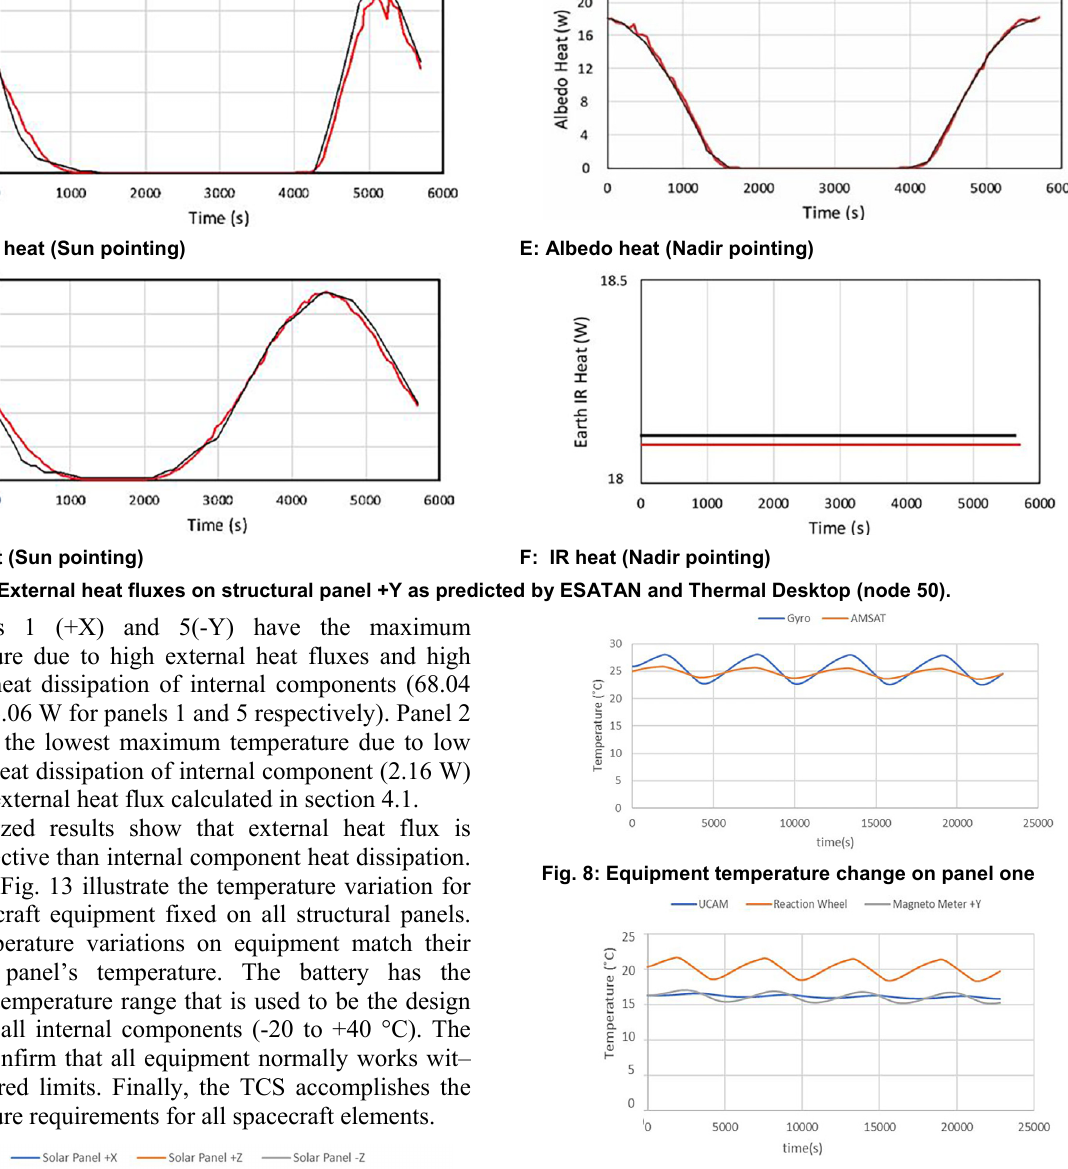
Fig. 9: Equipment temperature change on panel two